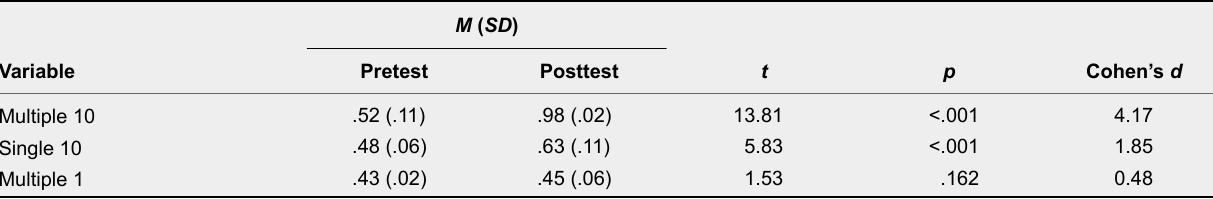
Linearity (R 2 Lin ) at Pretest and Posttest for Each Condition Variable